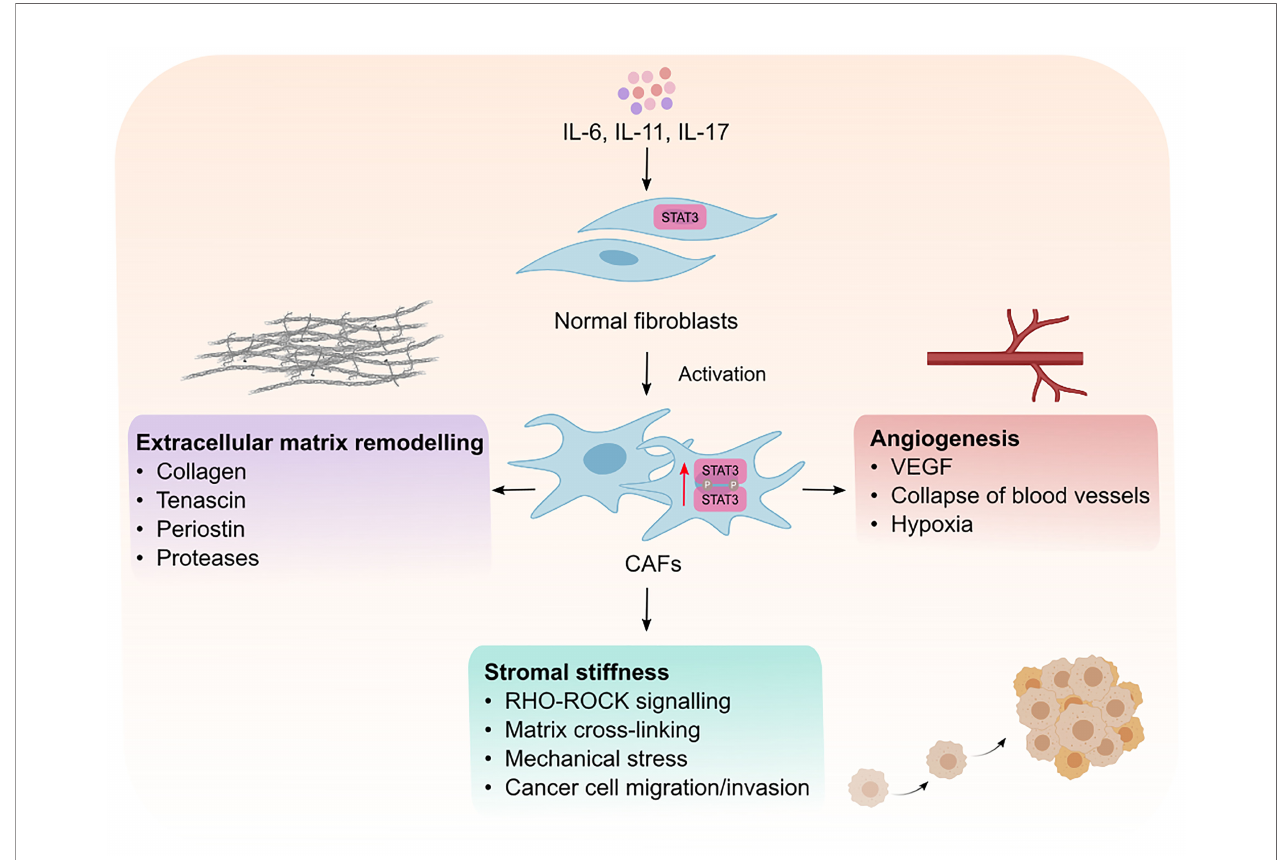
FIGURE 2 | Intrinsic effects of STAT3 signaling in CAFs. Cytokines such as IL-6, IL-11 and IL-17 mediate the phosphorylation and activaton of STAT3 resulting in the transformation of normal fi broblasts into cancer associated fi broblasts (CAFs). Activated CAFs can then remodel the extracellular matrix, promote matrix cross- linking leading to stromal stiffness and mechanical stress. Mechanical stresses in the stroma consequently leads to the collapse of blood vessels and induction of hypoxia which creates an environment permissible to tumor development. CAFs can also promote tumor vascularization which facilitates the migration and invasion of cancer cells to distant sites. VEGF; vascular endothelial growth